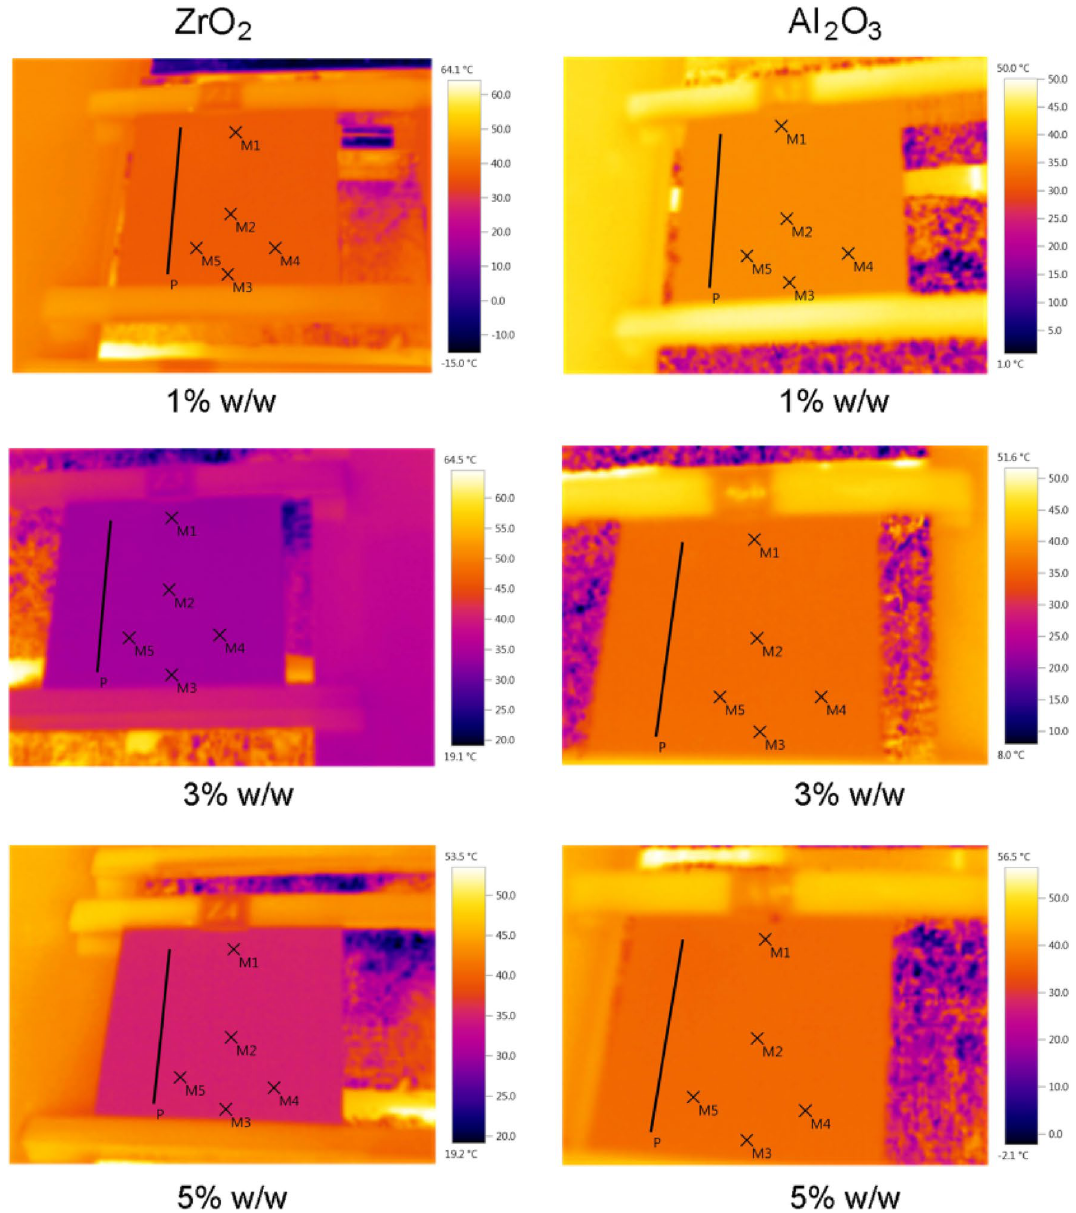
Figure 6. Thermography of images of polyurethane nanocomposite coatings with different amounts of nano ZrO 2 and Al 2 O 3